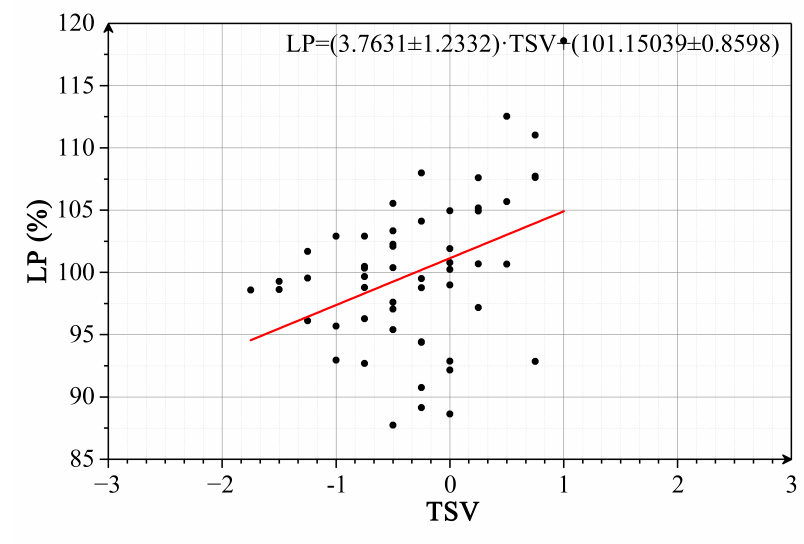
Figure 21. The quantitative relationship between TSV and LP. Secondly, the relationship between PMV and LP is presented in Figure 22. The results were similar to those of the TSV-LP, but there was some error. This is probably because the subject students were informed of the actual temperature before the actual heat sensation voting, and the PMV model was built under the condition that the tested students didn’t know the actual environmental parameters. Therefore, the error could be a psychological effect of the asymmetry of information on the students during the actual heat sensation voting.